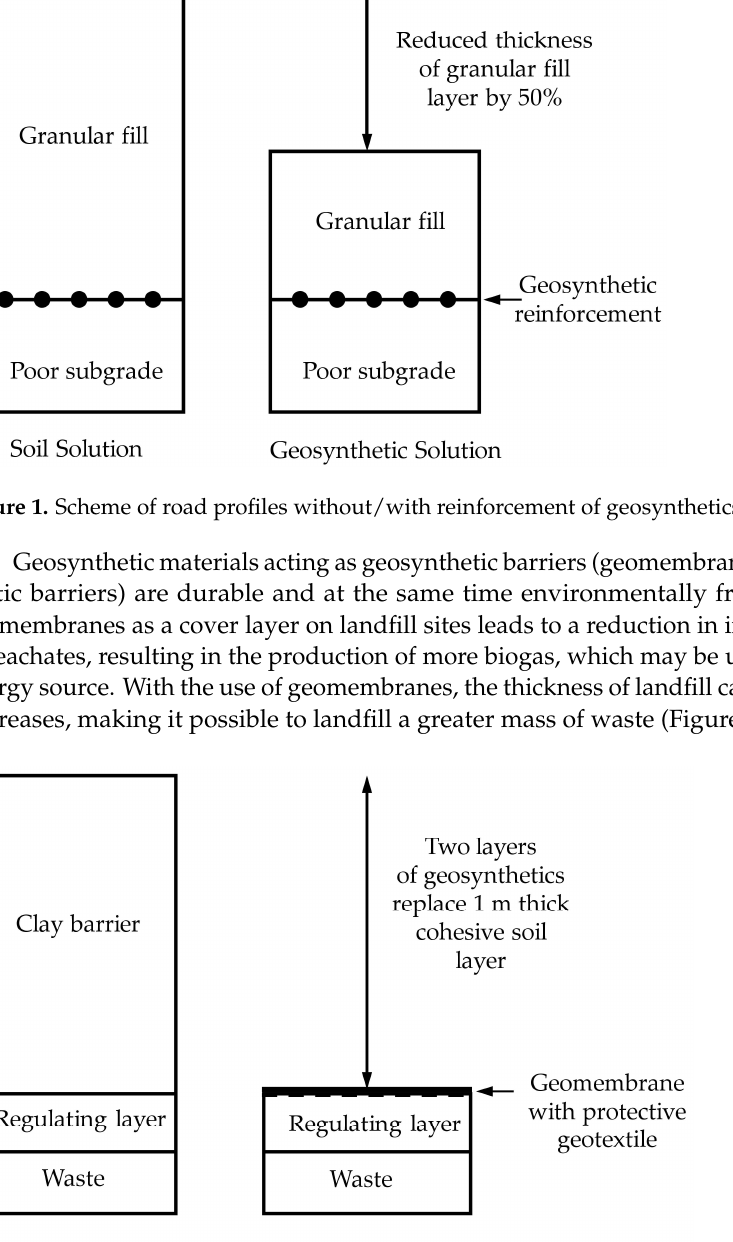
Figure 1. Scheme of road profiles without/with reinforcement of geosynthetics, adapted from [42].